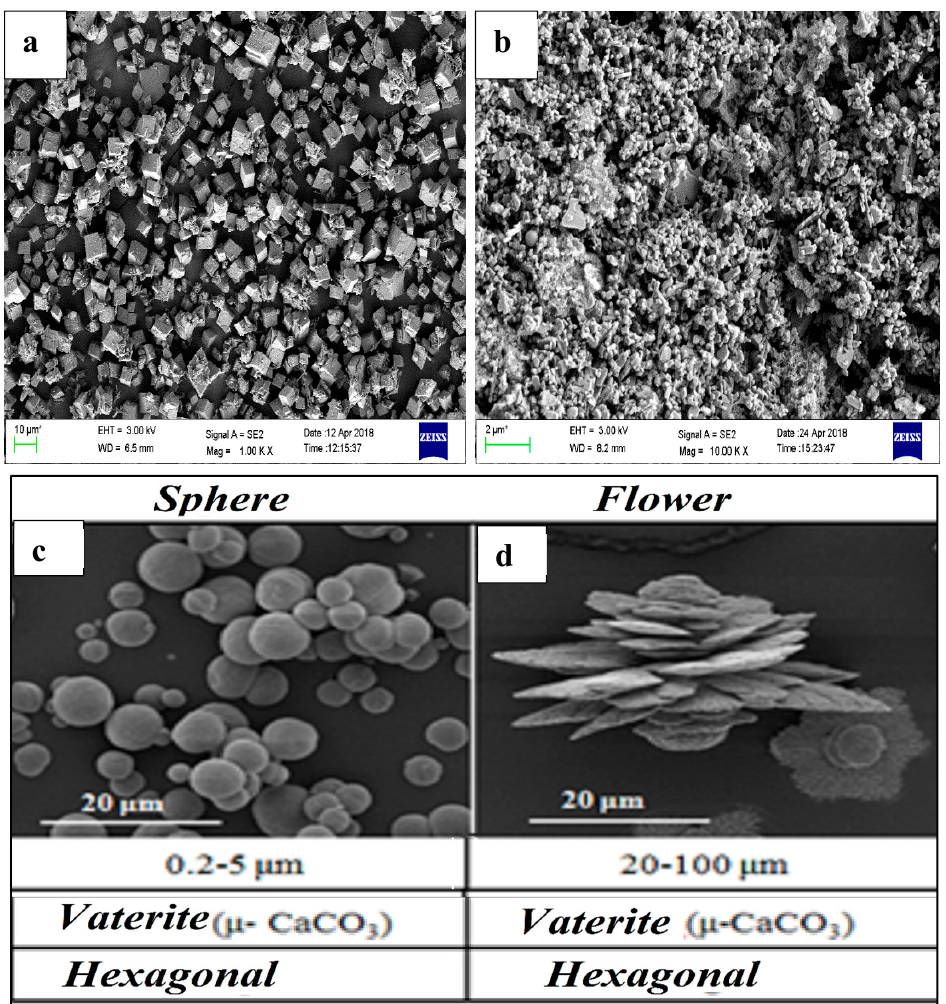
Figure 11. FESEM of ( A ) nano calcite; ( B ) aragonite; ( C ) spherical vaterite; ( D ) floral vaterite [89] .